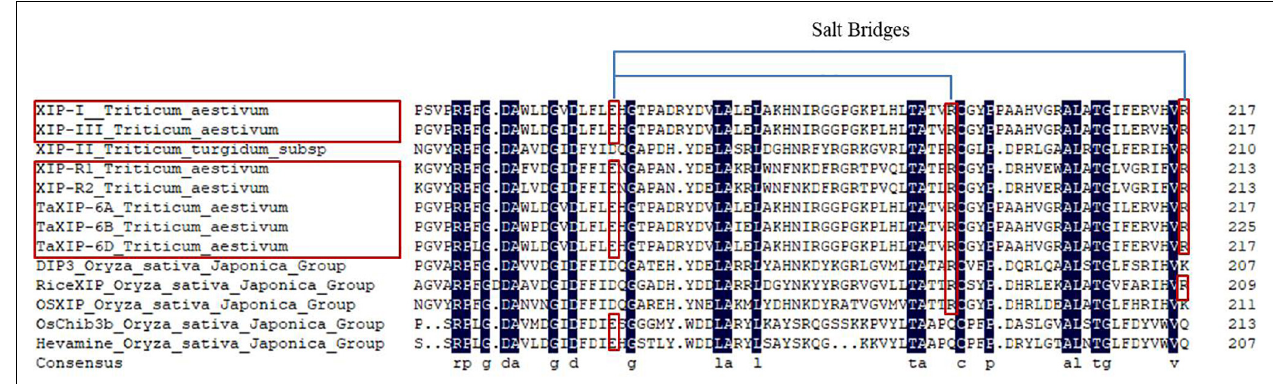
FIGURE 2 | Comparison of the amino acid residues surrounding the chitinase “active site” region of XIPs and chitinase. Conserved amino acid residues are shaded. The two Arg residues (red boxed) and the catalytic Glu residue are joined by blue lines. The names of the sequences with salt bridges are boxed in red. Genbank accession numbers are as follows: XIP-I: CAD19479.1; XIP-II: CAC87260.1; XIP-III: BAD99103.1; XIP-R1: BAF74363.1; XIP-R2: BAF74364.1; RiceXIP: BAG89082.1; DIP3: AFM95334.1; OSXIP: AXF92897.1; OsChib3b: